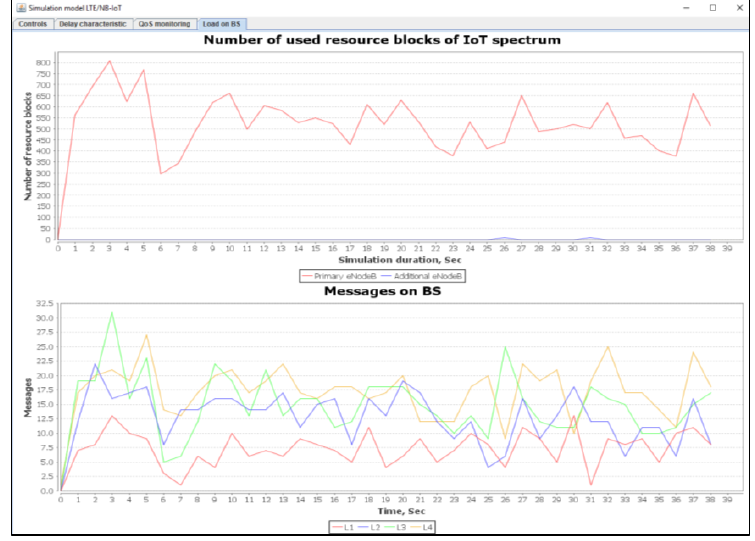
Figure 12. Used IoT spectrum resource blocks and transmitted messages ratios with different priorities (average load of IoT controller ρ = 12%).